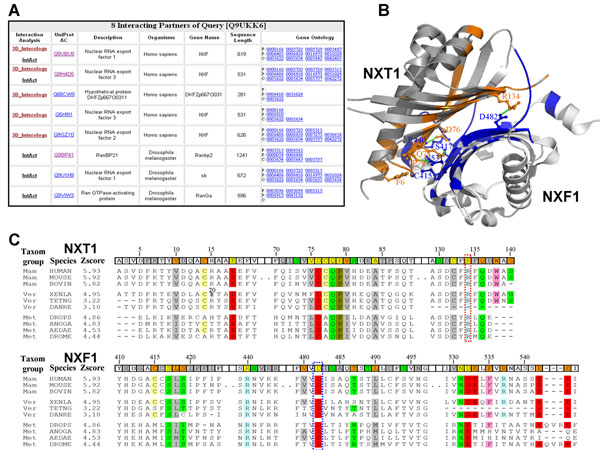
The 3D-interologs database search results of using human NXT1 (UniProt accession number Q9UKK6) as query. (A) Eight interacting partners of NXT1 are found in the 3D-Interologs. For each interacting partner, this server provides UniProt accession number, protein description, organism and Gene Ontology annotation. (B) Detailed interactions between the query and its interacting partner (UniProt accession number Q9UBU9) are indicated via the structure template which consists of NXT1 (PDB entry 1jkg-A) and NXF1 (PDB entry 1jkg-B). The contact residues of NXT1 (query side) and NXF1 (partner side) are colored by red and blue, respectively. The contact residues forming hydrogen bonds (green and dash) are given the atom details. (C) The interacting evolution analysis by using multiple sequence alignments of hit interacting partners of the query across multiple species. The 3D- interologs yields 10 interologs of the query template structure. The contacted residues are marked in template structure based on their interacting characteristics, including hydrogen-bond residues (green); conserved residues (orange); both (yellow), and others (gray). The couple-conserved contact positions are colored in the multiple alignments according to the physical-chemical property of amino acid residues. Twenty amino acid types are classified into 7 groups, namely polar positive (His,Arg, and Lys, blue); polar negative (Asp and Glu, red); polar neutral (Ser, Thr, Asn and Gln, green); cystein (yellow); non-polar aliphatic (Ala, Val, Leu, Ile and Met, gray); non-polar aromatic (Phe, Tyr and Trp, pink); and others: (Gly and Pro, brown).